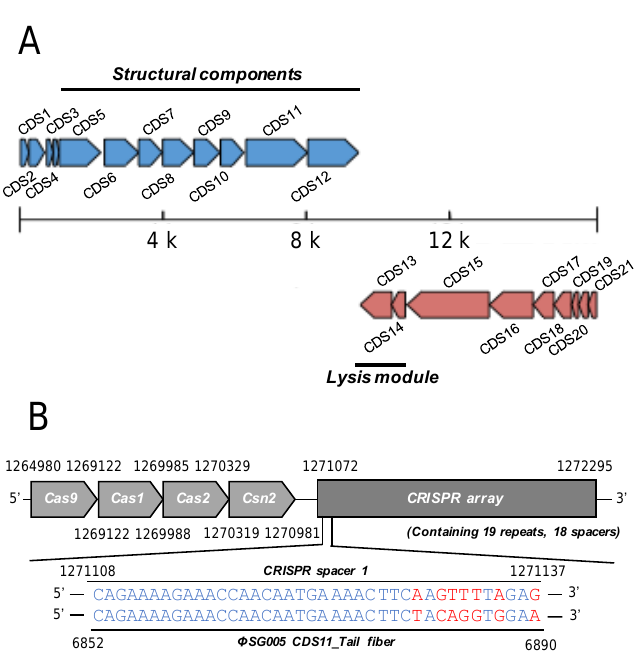
Figure 3. Genome structure of Ø SG005. ( A ) Ø SG005 possesses 16,127 bp and a total of 21 CDSs indicated as blue or red arrows (complementary). Putative structural components (from CDS4 to CDS12) and putative lysis modules (CDS13 and CDS14) are marked by solid lines. ( B ) A section of the CRISPR-associated region in S. gordonii ATCC10558 is depicted. S. gordonii ATCC10558 harbors the type II CRISPR-Cas system composed of Cas9, Cas1, Cas2, and Csn2 (1,264,980 – 1,270,981 bp). The CRISPR array contains 19 repeats and 18 spacer sequences. One of the CRISPR spacers located at the most 5′ proximal region in the CRISPR array (represented as CRISPR spacer 1) shows high similarity with the sequence of the Ø SG005 CDS11 predicted tail fiber.